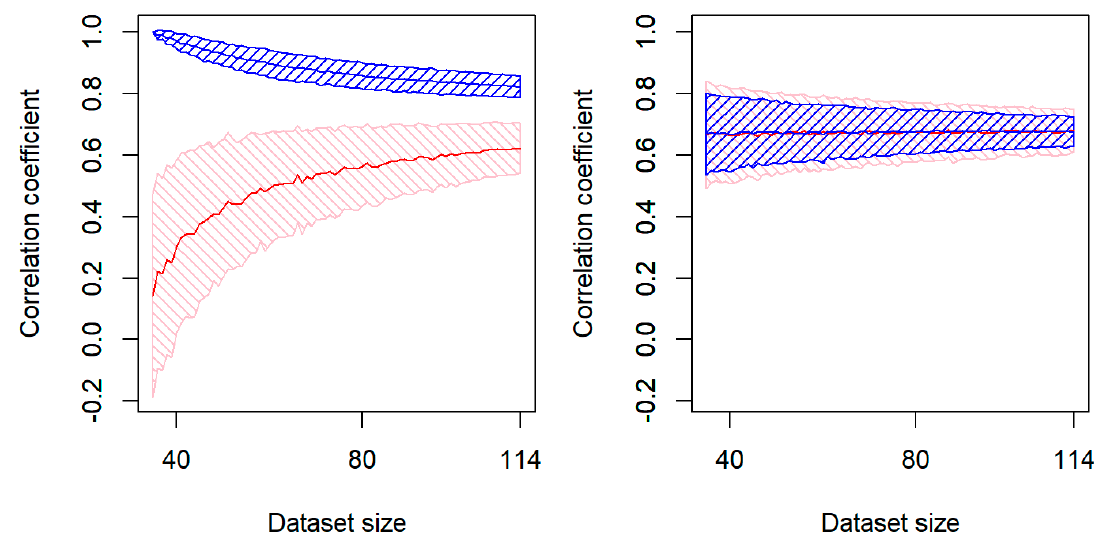
Figure 4. Learning curves for the model having 19 adjustable parameters based on the amino acid occurrences in proteins having di ff erent folding times (left). For sub-datasets of di ff erent sizes ( x -axis) sampled randomly from the general experimental dataset for 114 proteins, the 60% and 40% of the sub-dataset were used for training and testing the model, respectively. The shaded area depicts the most frequently observed values of the correlation coe ffi cient (within one standard deviation from the average value): Blue and red for the training and testing sets, respectively (left). The same for the above described (see Equation (2) and Figures 2 and 3) model, where t = τ × exp[ L 2 / 3 ], that has no adjustable parameters (right). Adapted from [99] with minor modifications.